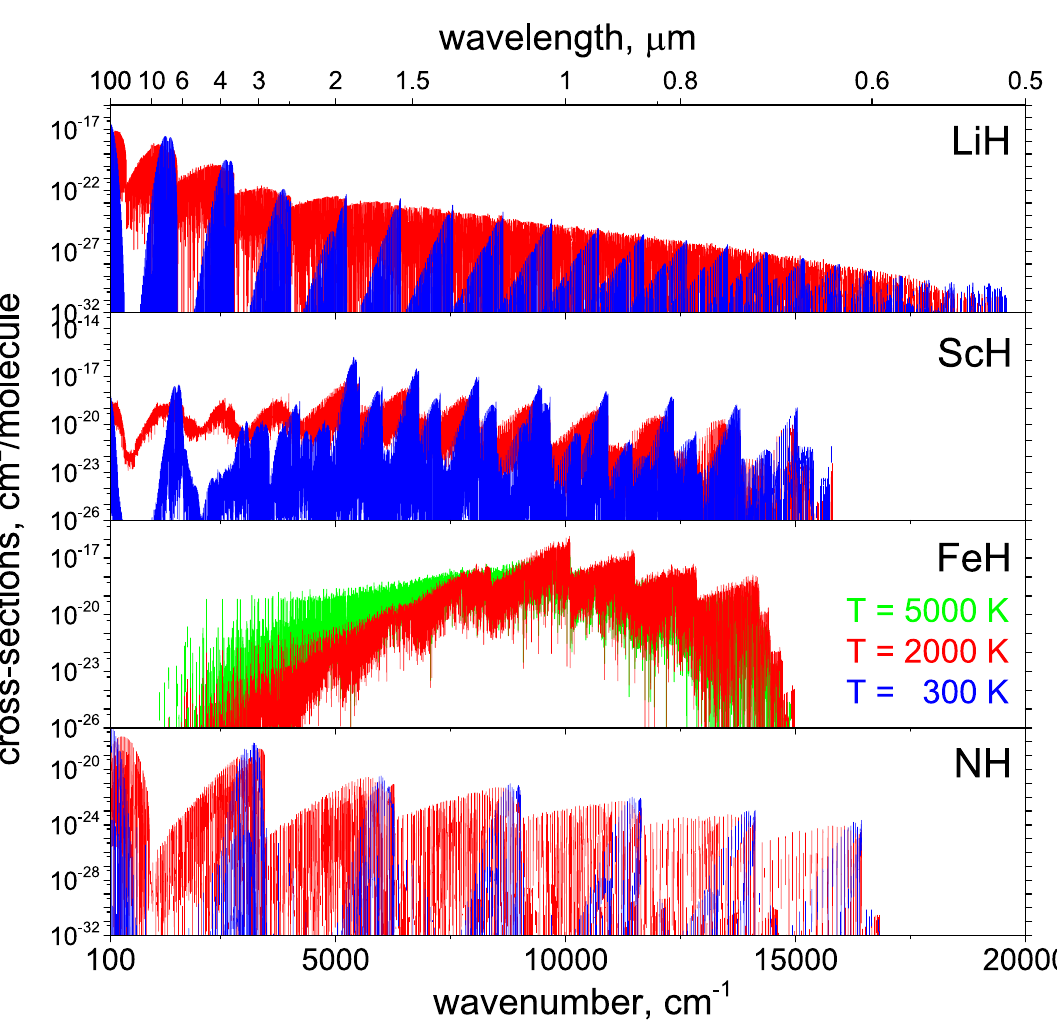
Figure 12. Cross sections for metal hydrides and NH. Line lists for lithium hydride [80] and scandium hydride [81] are theoretical while those for FeH and NH are derived from the experiments of the Bernath group